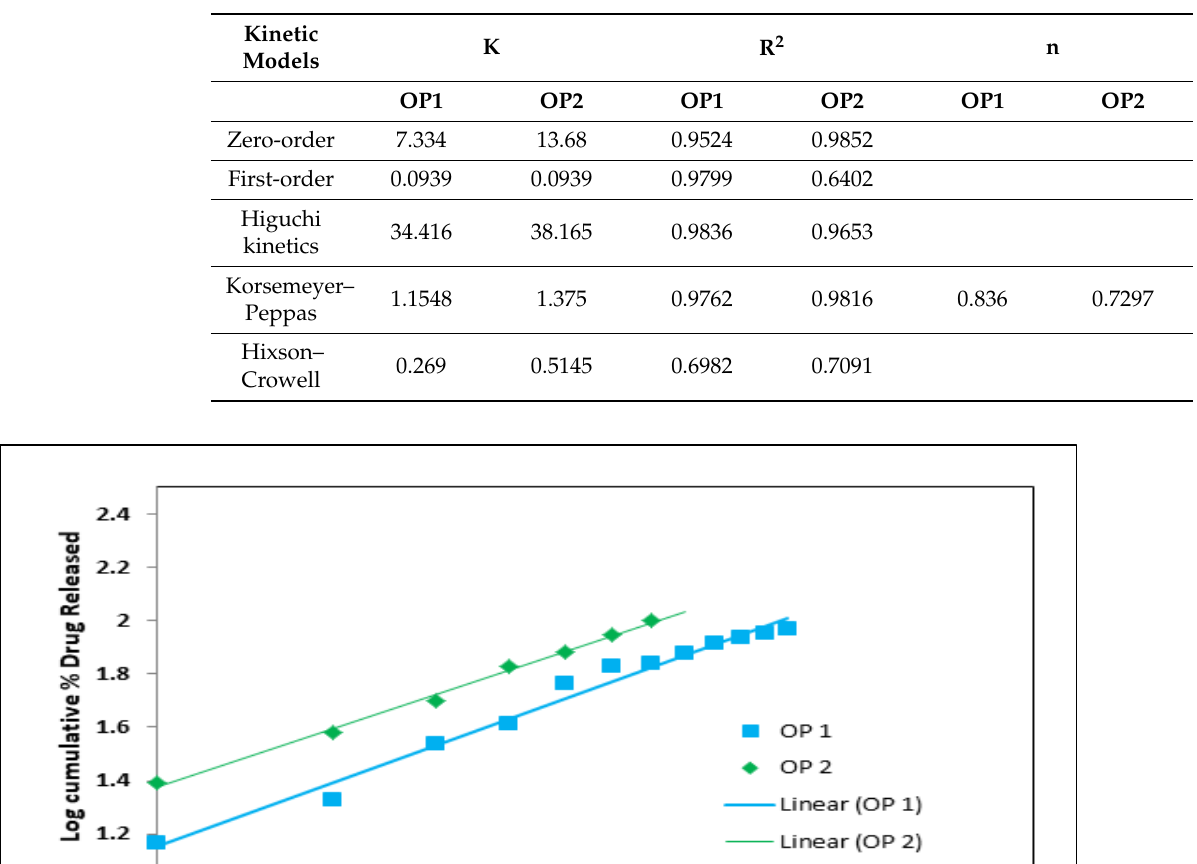
Table 9. In vitro release profile of optimized formulation (OP1 and OP2) in various models.